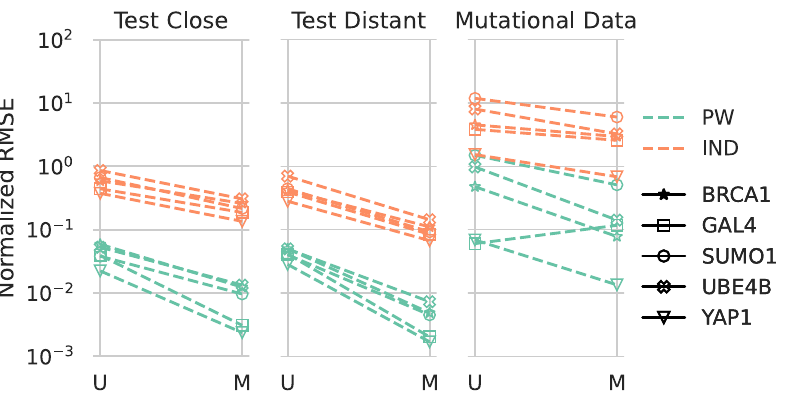
Fig 5. Errors in energies of the extracted pairwise and independent models with respect to the original ArDCA models. The three columns correspond to three different datasets: “Test Distant” corresponds to the 10% of sequences in the test set that have the largest distance to the training set in terms of minimum Hamming distance, “Test Close” to the remaining sequences. The right-most column corresponds to the sequences in the mutational datasets. The colors indicate whether the extracted model is an independent model (orange) or a pairwise model (green). Within every column, the left bar (U) corresponds to models extracted with samples from the uniform distribution, the right bar (M) to models extracted with samples from the distribution of the original models. The error shown is the normalized root-mean squared error (see Eq 8. Note the logarithmic scale.